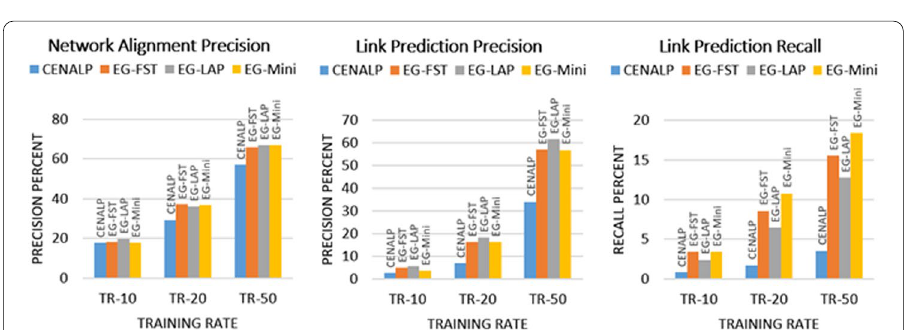
Fig. 5 Network alignment precision and link prediction precision and Recall on Douban on CENALP, EG-FST, EG-LAP and EG-Mini